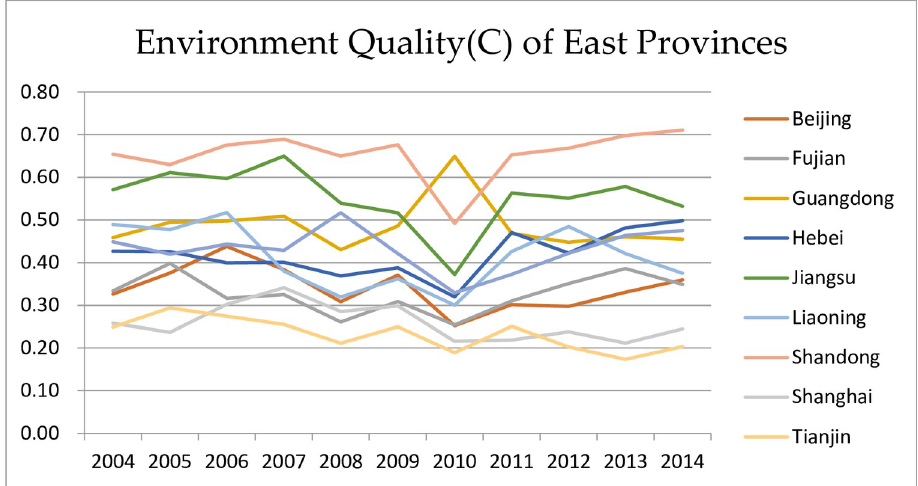
Fig 4. Environment quality (C) of East Region.